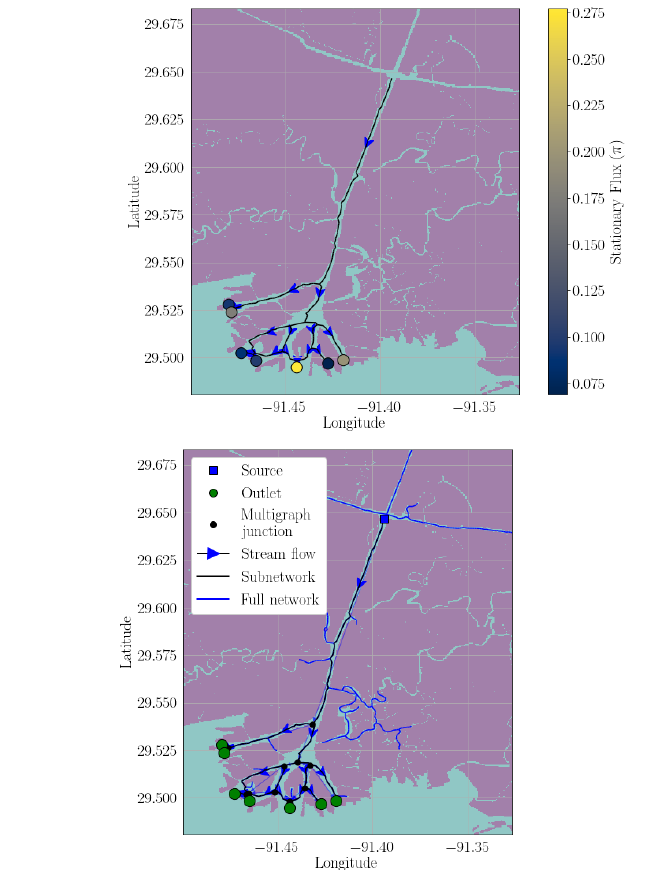
Figure 5. Using the channel network from the OSM water mask, we compute the steady state fluxes to estimate the percentage of discharge from each outlet in the Wax Lake considering a source chosen just south of the Intracoastal Waterway. The topmost panel shows the stationary fluxes normalized across the outlets. The bottom panel illustrates the directed multigraph to compute the flux and normalized entropy rate. In the bottom panel, the source (blue square) and the outlets (green circles) are connected in our computation of the stationary distribution π described in